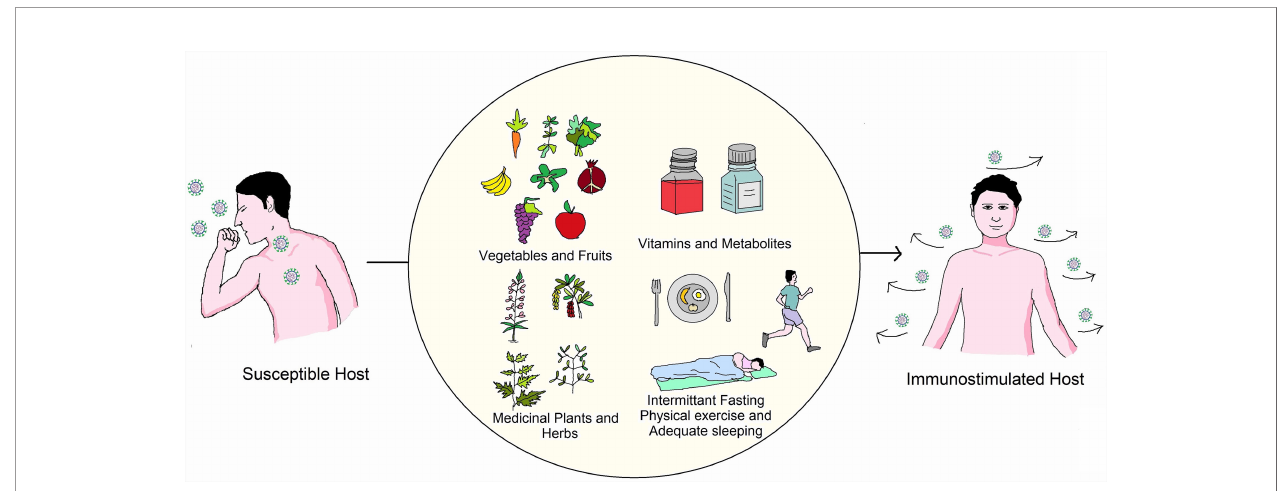
FIGURE 1 | Overview of measures essential to boost immunity against COVID-19. One can boost immunity by using proper guidelines of a healthy lifestyle (Adequate food, physical exercise,